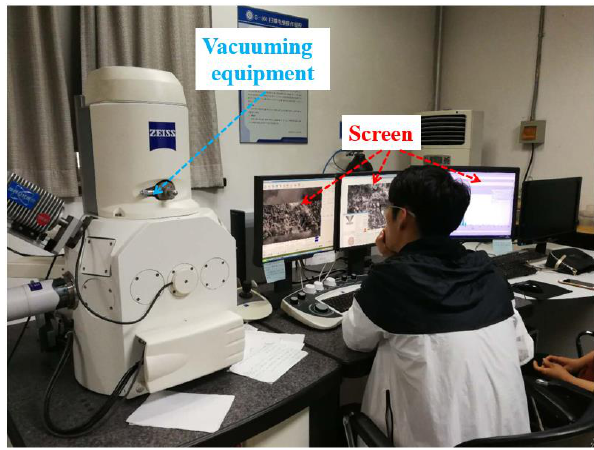
Figure 5. An image of SEM testing apparatus.